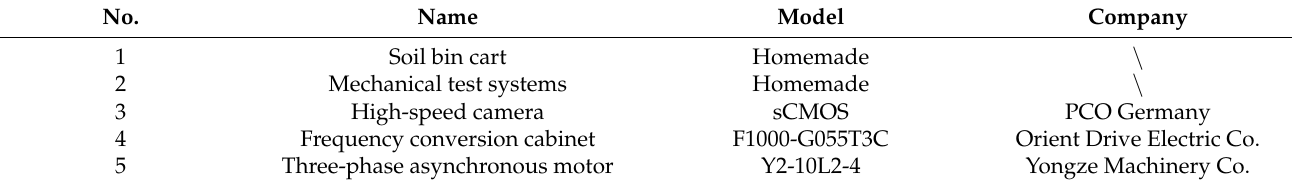
Table 7. Equipment model and parameters.